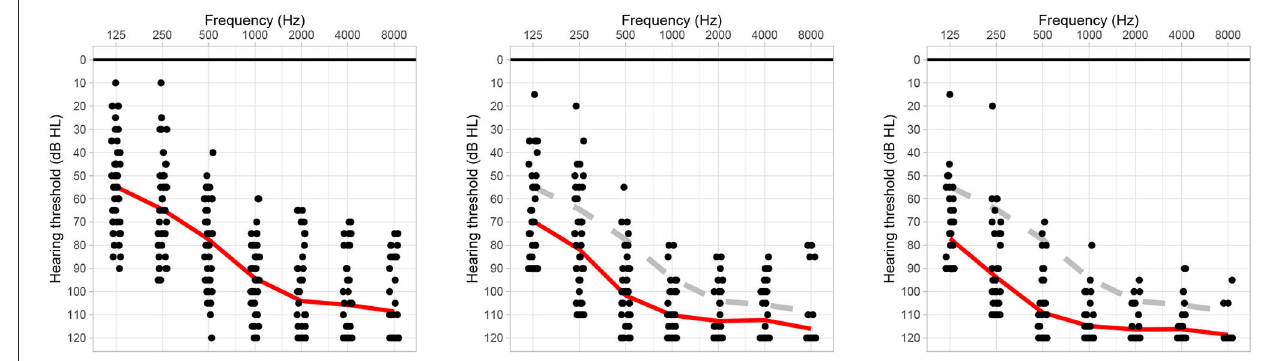
FIGURE 1 | Preoperative, 3-month postoperative, and 6-months or the next later follow-up session air conduction hearing thresholds (left, center, and right audiograms, respectively). The red line indicates the average hearing thresholds, the gray dashed line shows the preoperative reference.